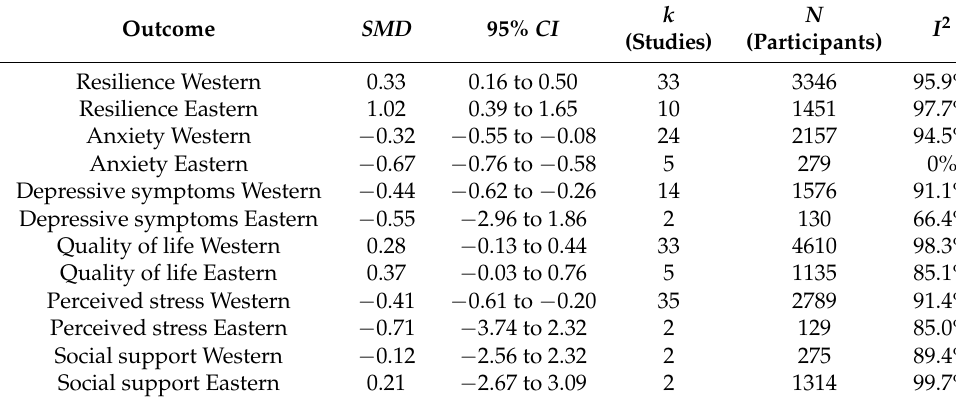
Table 3. Summary of pooled effect